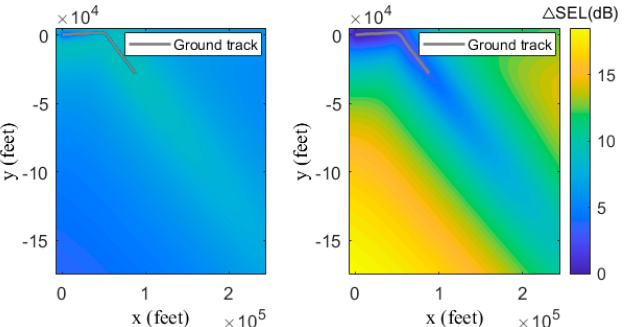
Figure 18. Effect of the atmospheric properties on the aircraft noise impact. Differences in SEL induced by a variation in relative humidity, as obtained for a given temperature (left: AD5—AD3, right: AD6—AD4).